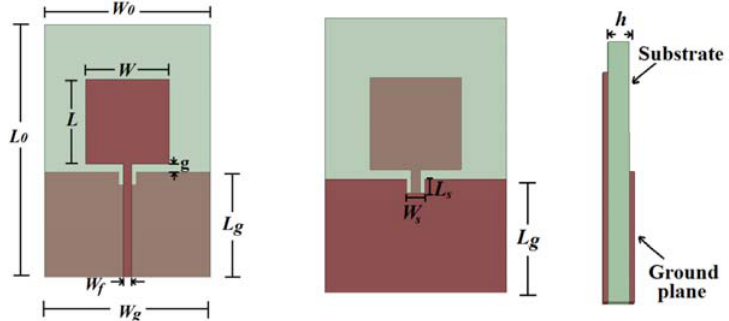
Figure 1. Geometry of a rectangular printed monopole antenna.